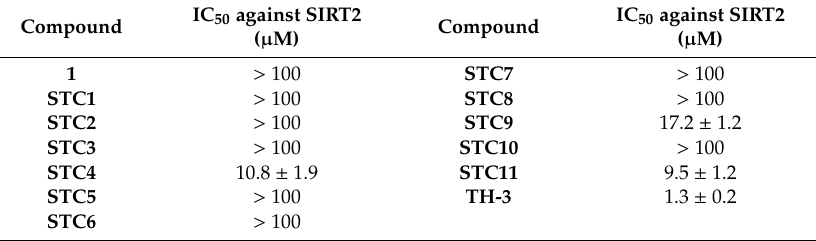
Figure 2. Design of new STLC derivatives targeting SIRT2 based on compound TH-3 (IC 50 against SIRT2 = 1.3 µ M) [29]. Table 1. In vitro inhibitory activity of STLC derivatives against